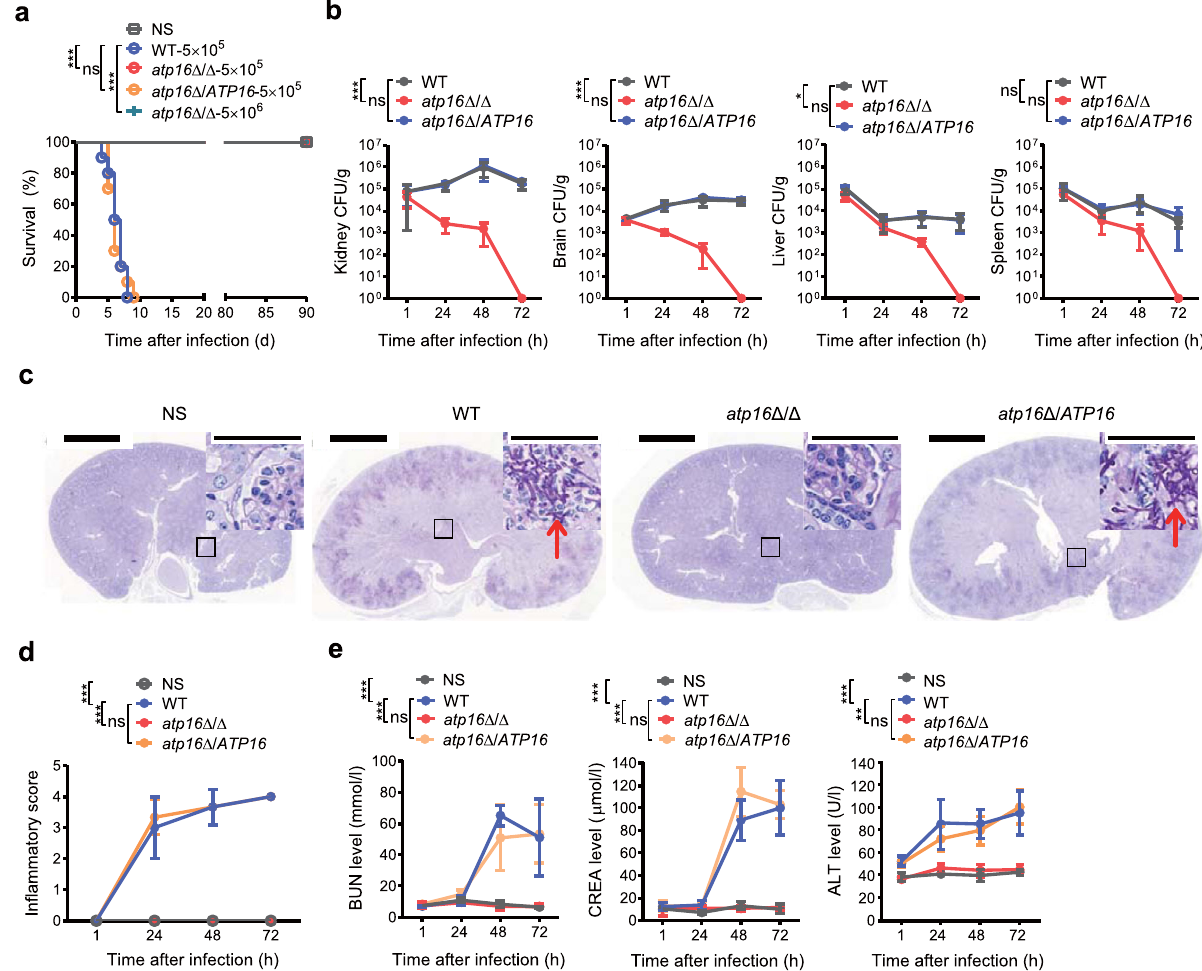
Fig. 1 A mutant C. albicans strain carrying a deletion of the δ subunit fails to cause lethal infection. a Survival curves of mice ( n = 10) after intravenous injection with NS and infection with C. albicans WT (5 × 10 5 colony-forming units (CFU) per mice), atp16 Δ / Δ (5 × 10 5 CFU per mice), atp16 Δ / ATP16 (5 × 10 5 CFU per mice), and atp16 Δ / Δ (5 × 10 6 CFU per mice). b C. albicans fungal burdens (CFU per g of tissue) in organs ( n = 3) 1, 24, 48 and 72 h after intravenous infection with WT, atp16 Δ / Δ , and atp16 Δ / ATP16 (5 × 10 5 CFU per mice). c , d Representative images of periodic acid-Schiff- (PAS) stained kidney sections of mice ( n = 3) 48 h after intravenous infection with WT, atp16 Δ / Δ , and atp16 Δ / ATP16 (5 × 10 5 CFU per mice) ( c ), and the combined in fl ammatory score based on renal immune cell in fi ltration (in fl ammation) and tissue destruction ( n = 3) 1, 24, 48 and 72 h after intravenous infection with WT, atp16 Δ / Δ , and atp16 Δ / ATP16 (5 × 10 5 CFU per mice) ( d ). Arrowheads indicate fungal hyphae. Insets show higher-magni fi cation images of the boxed areas; magni fi cation ×10, ×400 (insets). Scale bars, 2000 µ m, 50 µ m (insets). e Blood urea nitrogen, creatine and alanine aminotransferase levels of mice ( n = 3) 1, 24, 48 and 72 h after intravenous infection with WT, atp16 Δ / Δ , and atp16 Δ / ATP16 (5 × 10 5 CFU per mice). In c one representative experiment of three independent experiments is shown. In a , b , d and e , data are expressed as the mean ± SD. * P < 0.05, ** P < 0.01, *** P < 0.001; ns, not signi fi cant; by log-rank test ( a ), or two-way ANOVA ( b , d , e